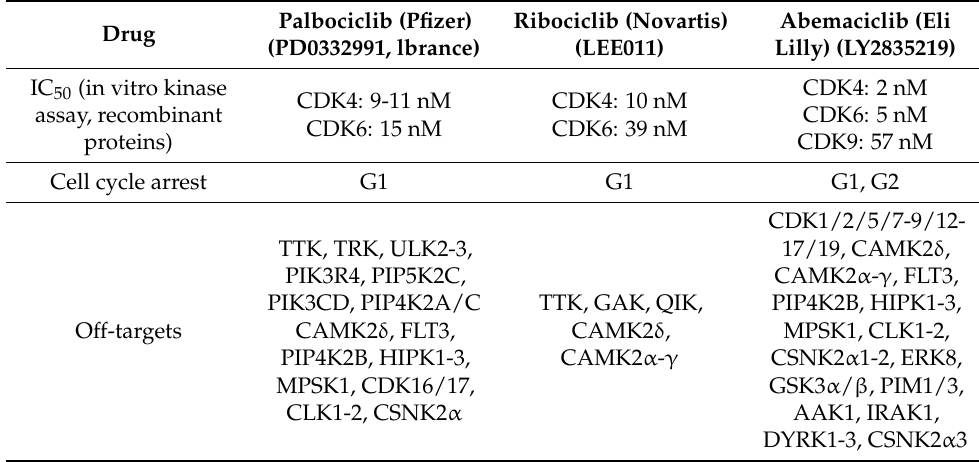
Table 1. Comparison of CDK4/6